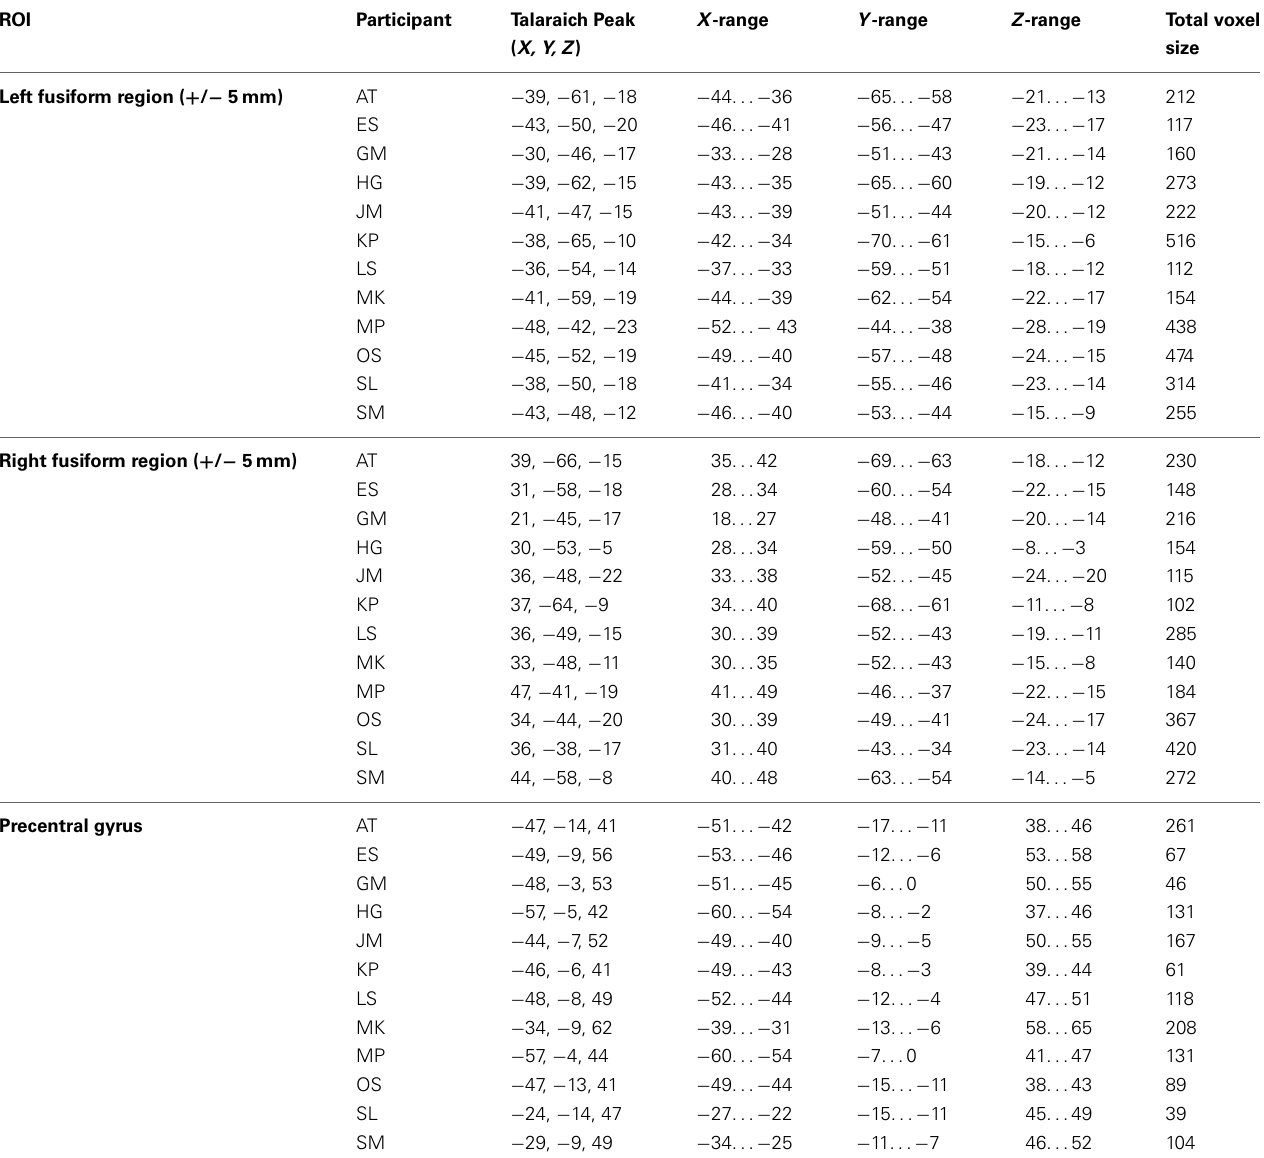
Table 2 | Peak Talairach coordinates and range for the Regions-of-Interest analyses. ROI Participant